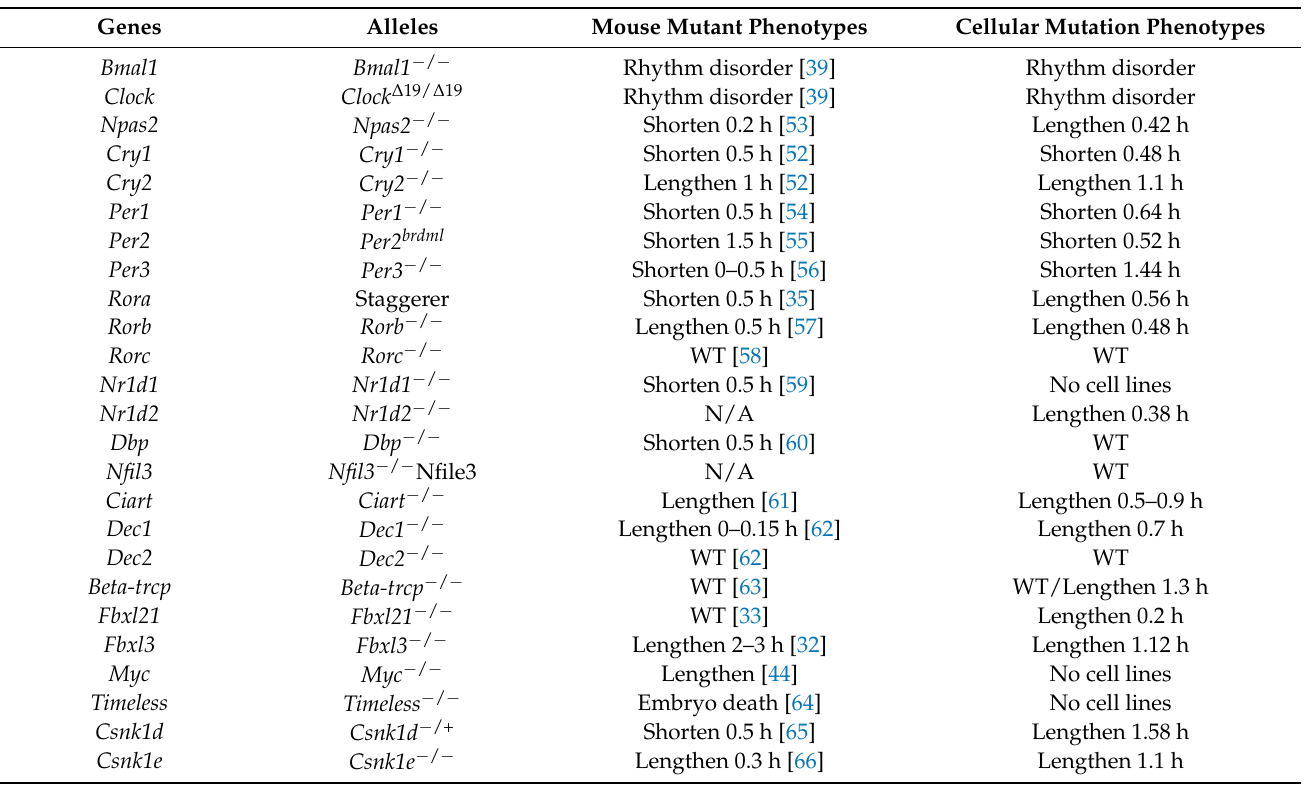
Table 1. Comparison of rhythm cycle changes between knockout mice and cell